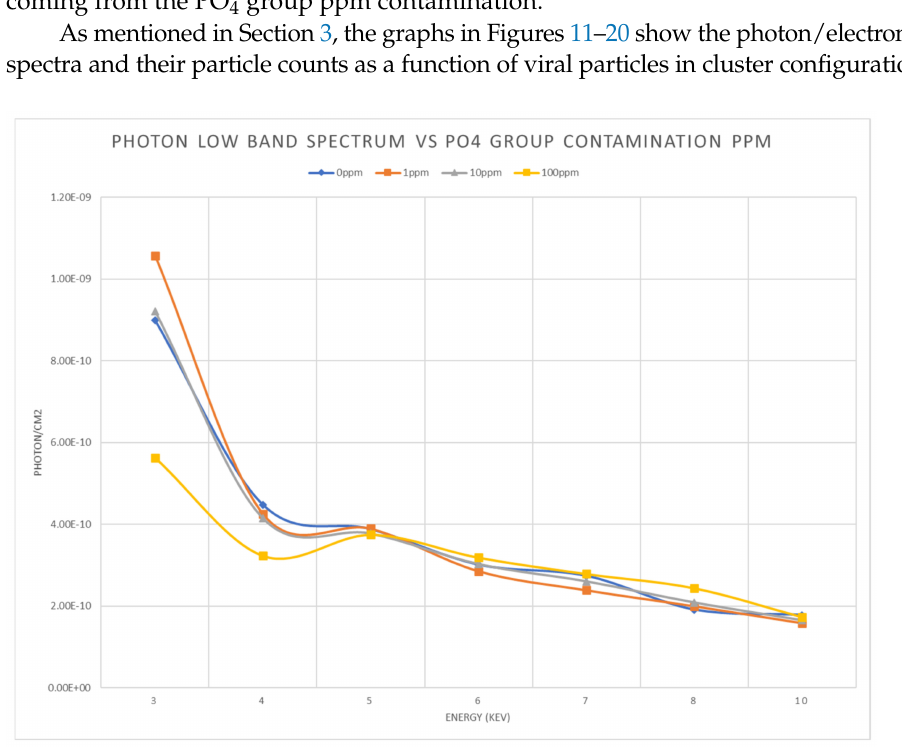
Figure 11. Low band photon spectrum A-air sample vs.